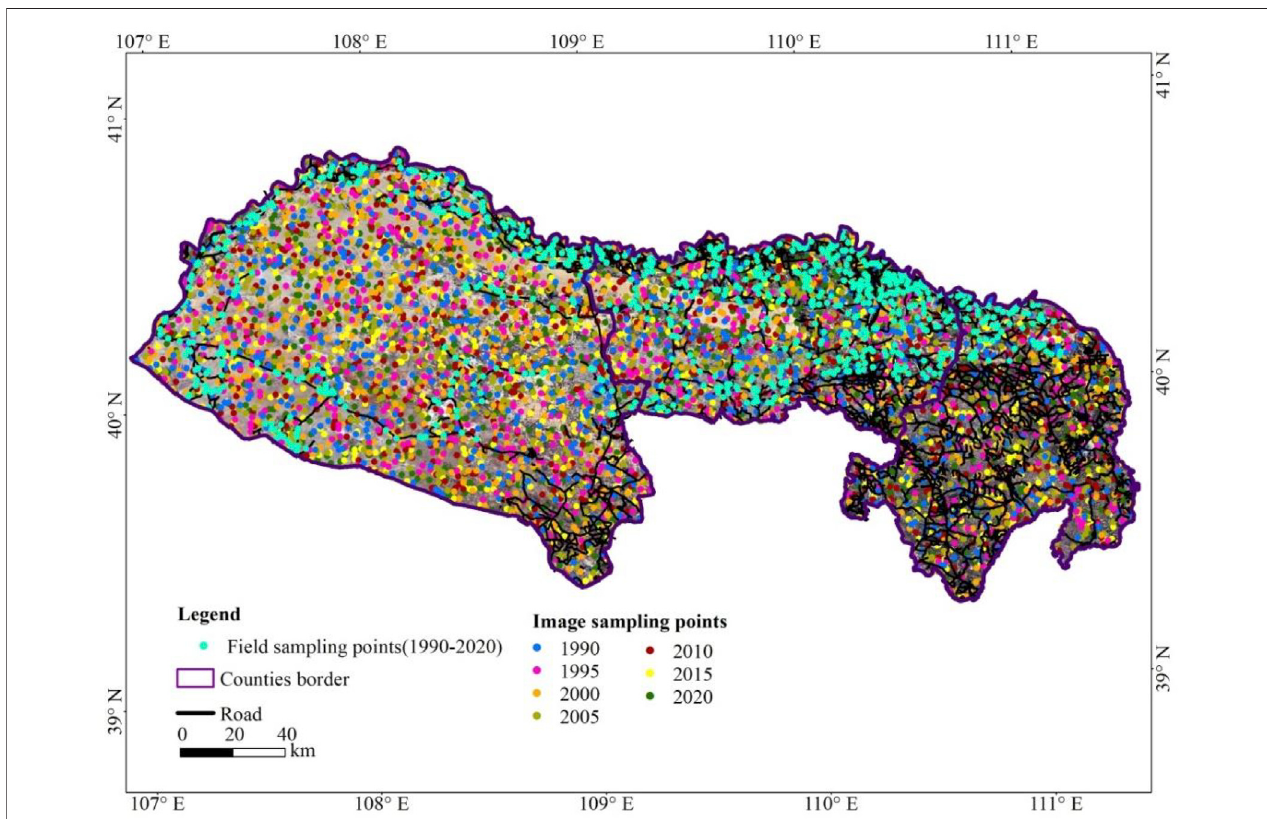
FIGURE 2 | Distribution of the sampling points and the fi eld survey points in different years.